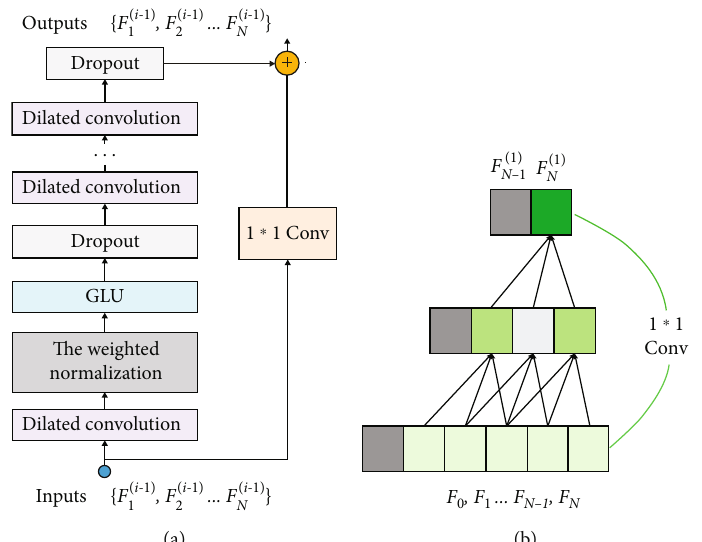
Figure 7: Structure of improved temporal feature extraction. (a) The composition structure of the overall framework. (b) Structure of Dilated Causal